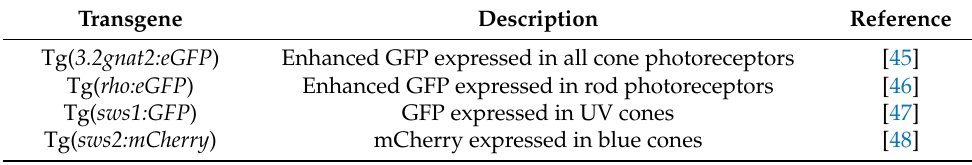
Figure 2. Zebrafish photoreceptor organization. ( A ) Cartoon depiction of the adult zebrafish photoreceptor mosaic. UV and blue cones, depicted in purple and blue respectively, alternate in their rows while red and green double cones alternate in neighbouring rows. Rods are studded throughout. ( B ) Fluorescent image of a flat-mounted adult transgenic zebrafish retina, with GFP expressed in UV cones (magenta) and mCherry expressed in blue cones (cyan). The alternation of UV and blue cones in their rows is apparent. ( C ) Immunofluorescent image of a cryosectioned adult Tg( sws1:GFP ) zebrafish retina with GFP in UV cones (green). UV opsin (red) and rhodopsin (magenta) are labelled, as well as nuclei (cyan). Table 1. Examples of common zebrafish transgenic lines with labelled photoreceptors.